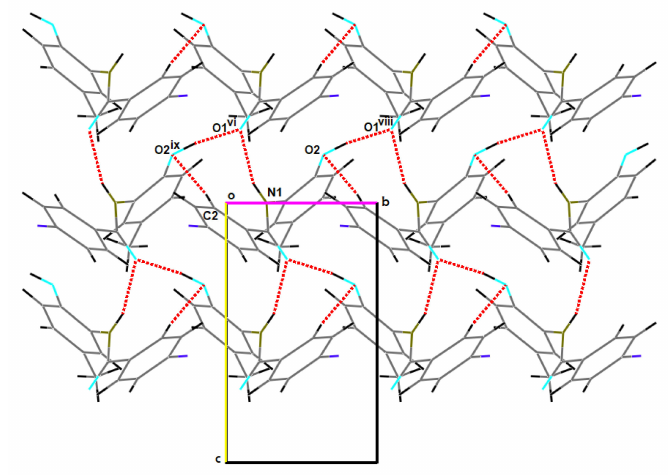
Figure 5. Part of the crystal structure of p -FPhB shows the formation of R 2 3 (9) and R 3 3 (17) edge-fused rings and a chain of molecules running along [001].